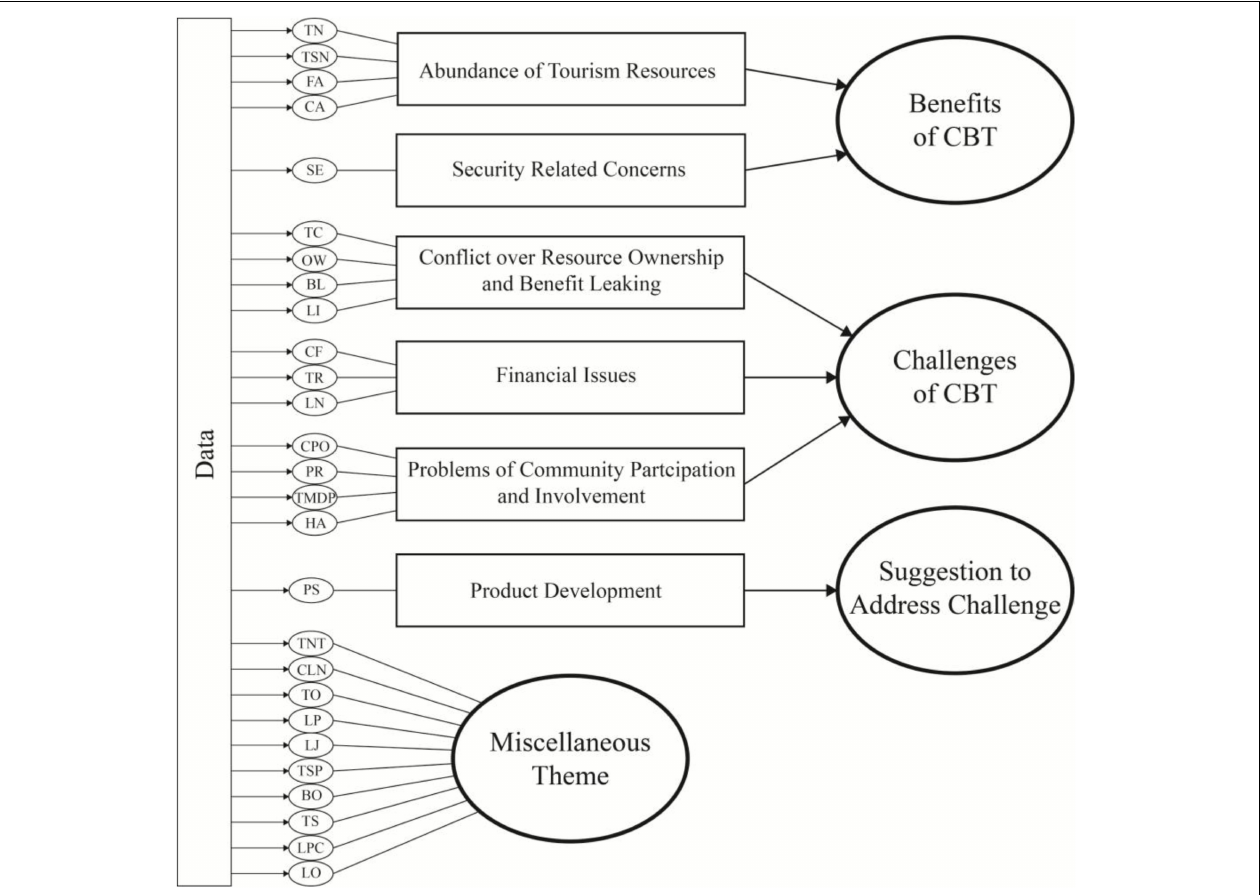
FIGURE 3 | Thematic